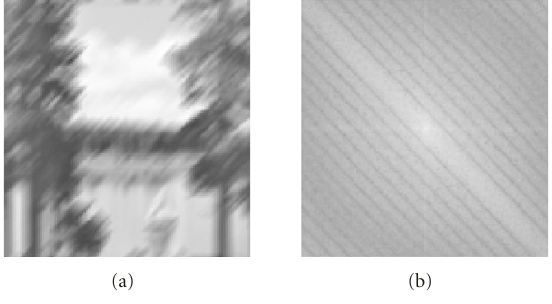
Figure 1: The frequency response of the uniform linear motion blur (a SINC shape function) with L = 7 . 5 pixels, φ = π/ 4.